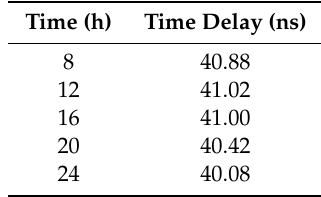
Table 2. Inherent time delay of GPS receiver.